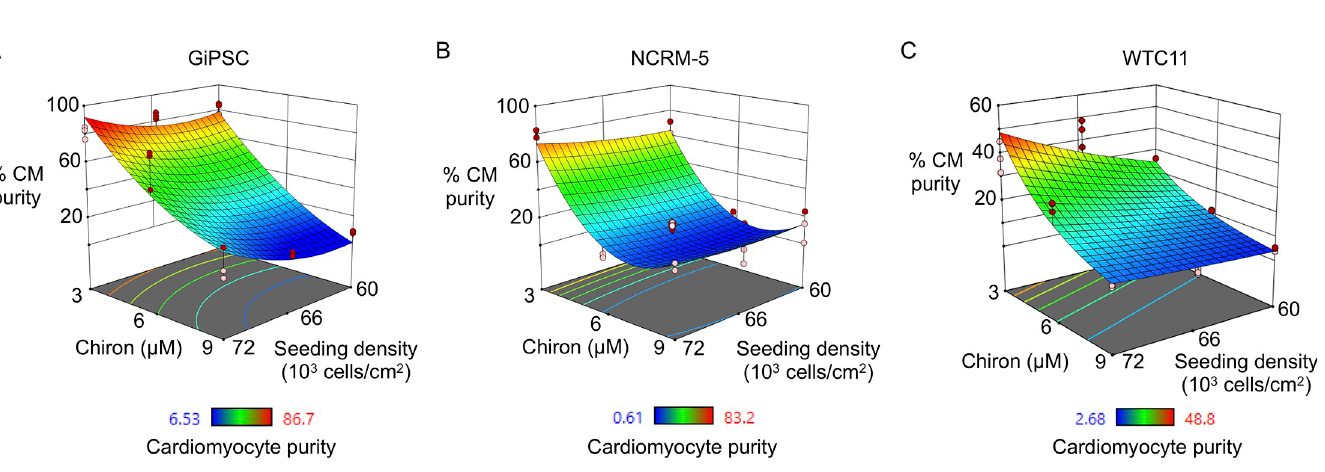
PLOS ONE | https://doi.org/10.1371/journal.pone.0230001 March 10,